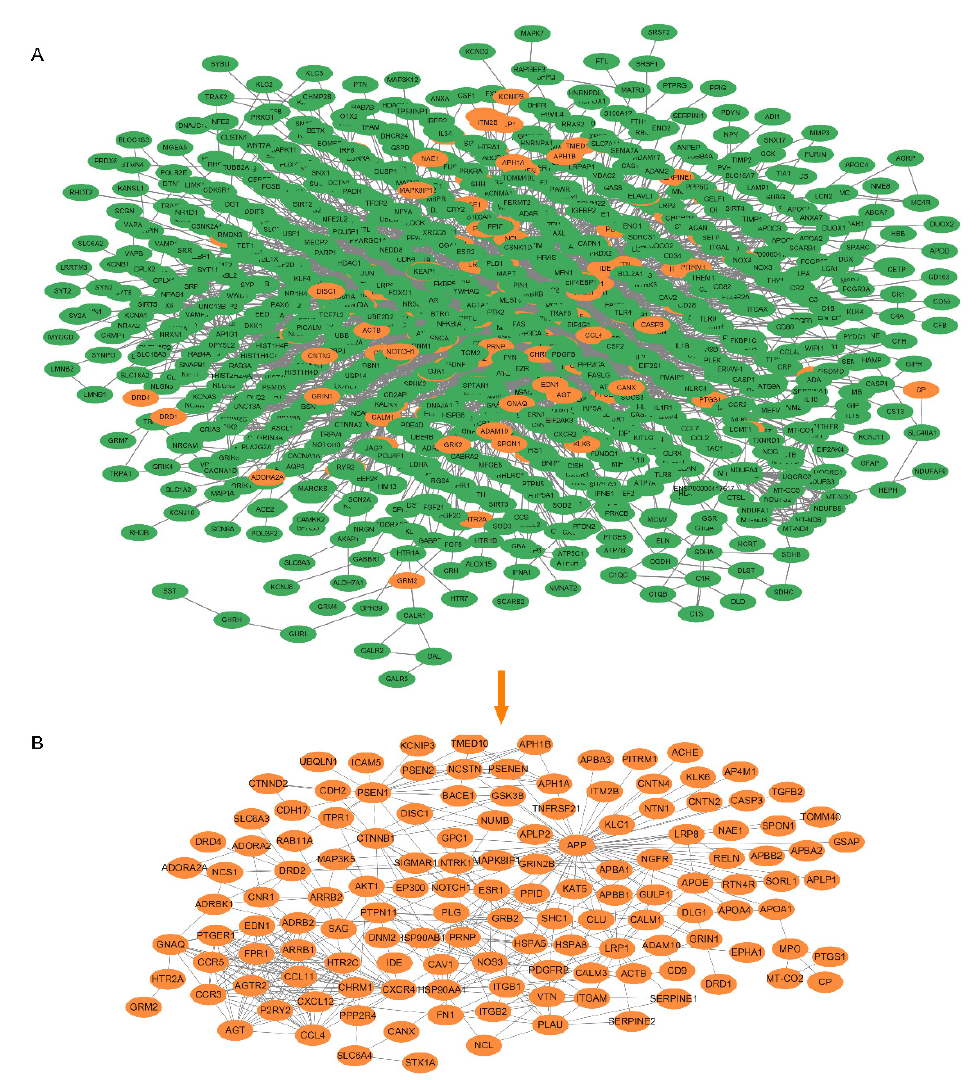
Figure 4. Subnetwork construction. ( A ) AD background network and ( B ) DS-AD network (subnet- work for Danshen-treated).